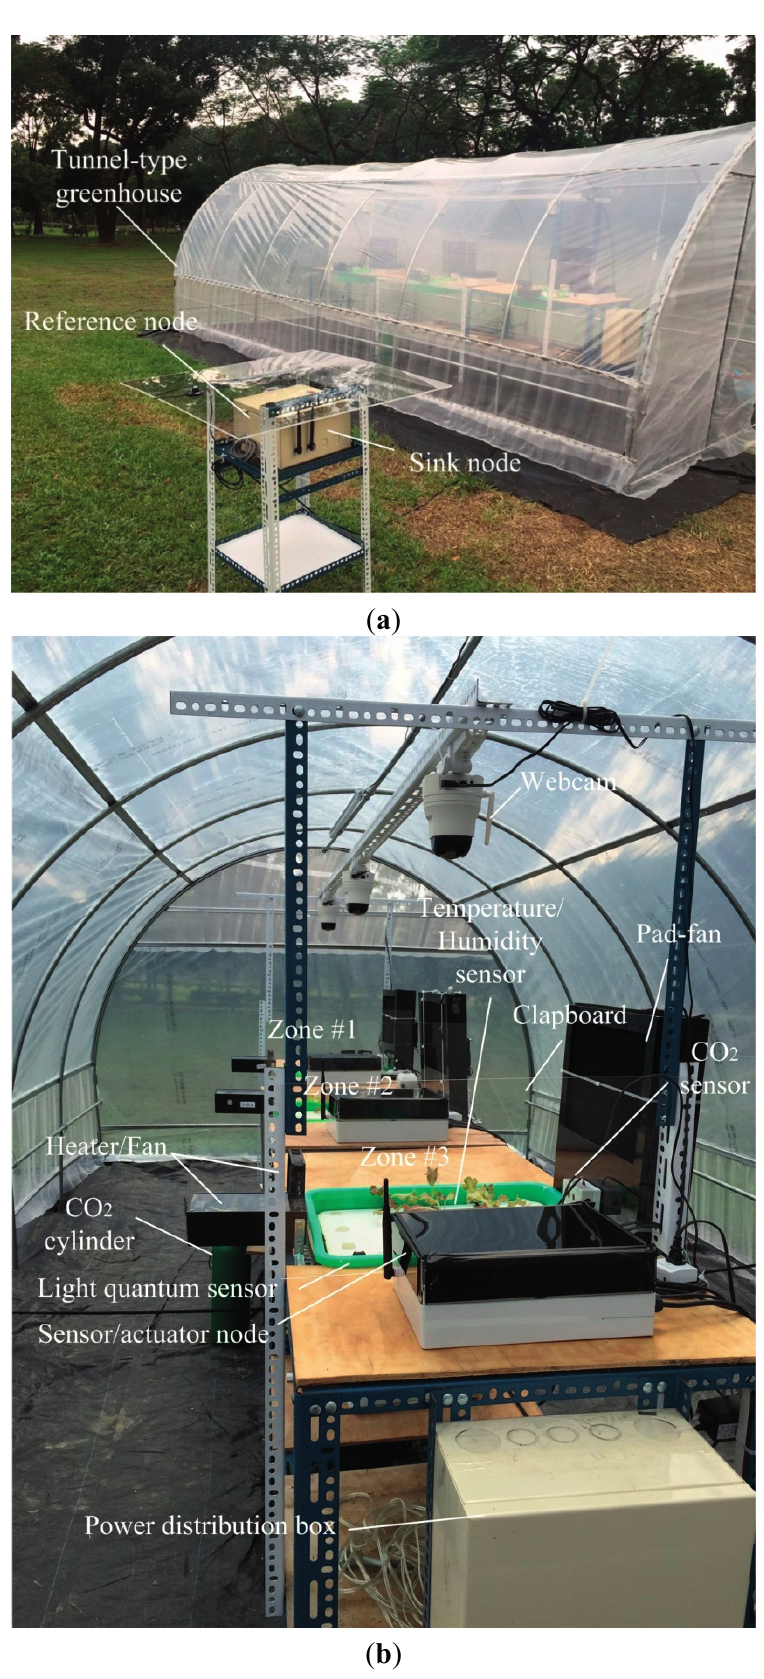
Figure 9. The configuration of plant cultivation zones in experimental site. ( a ) Appearance of tunnel-type greenhouse; ( b ) snapshot of experimental